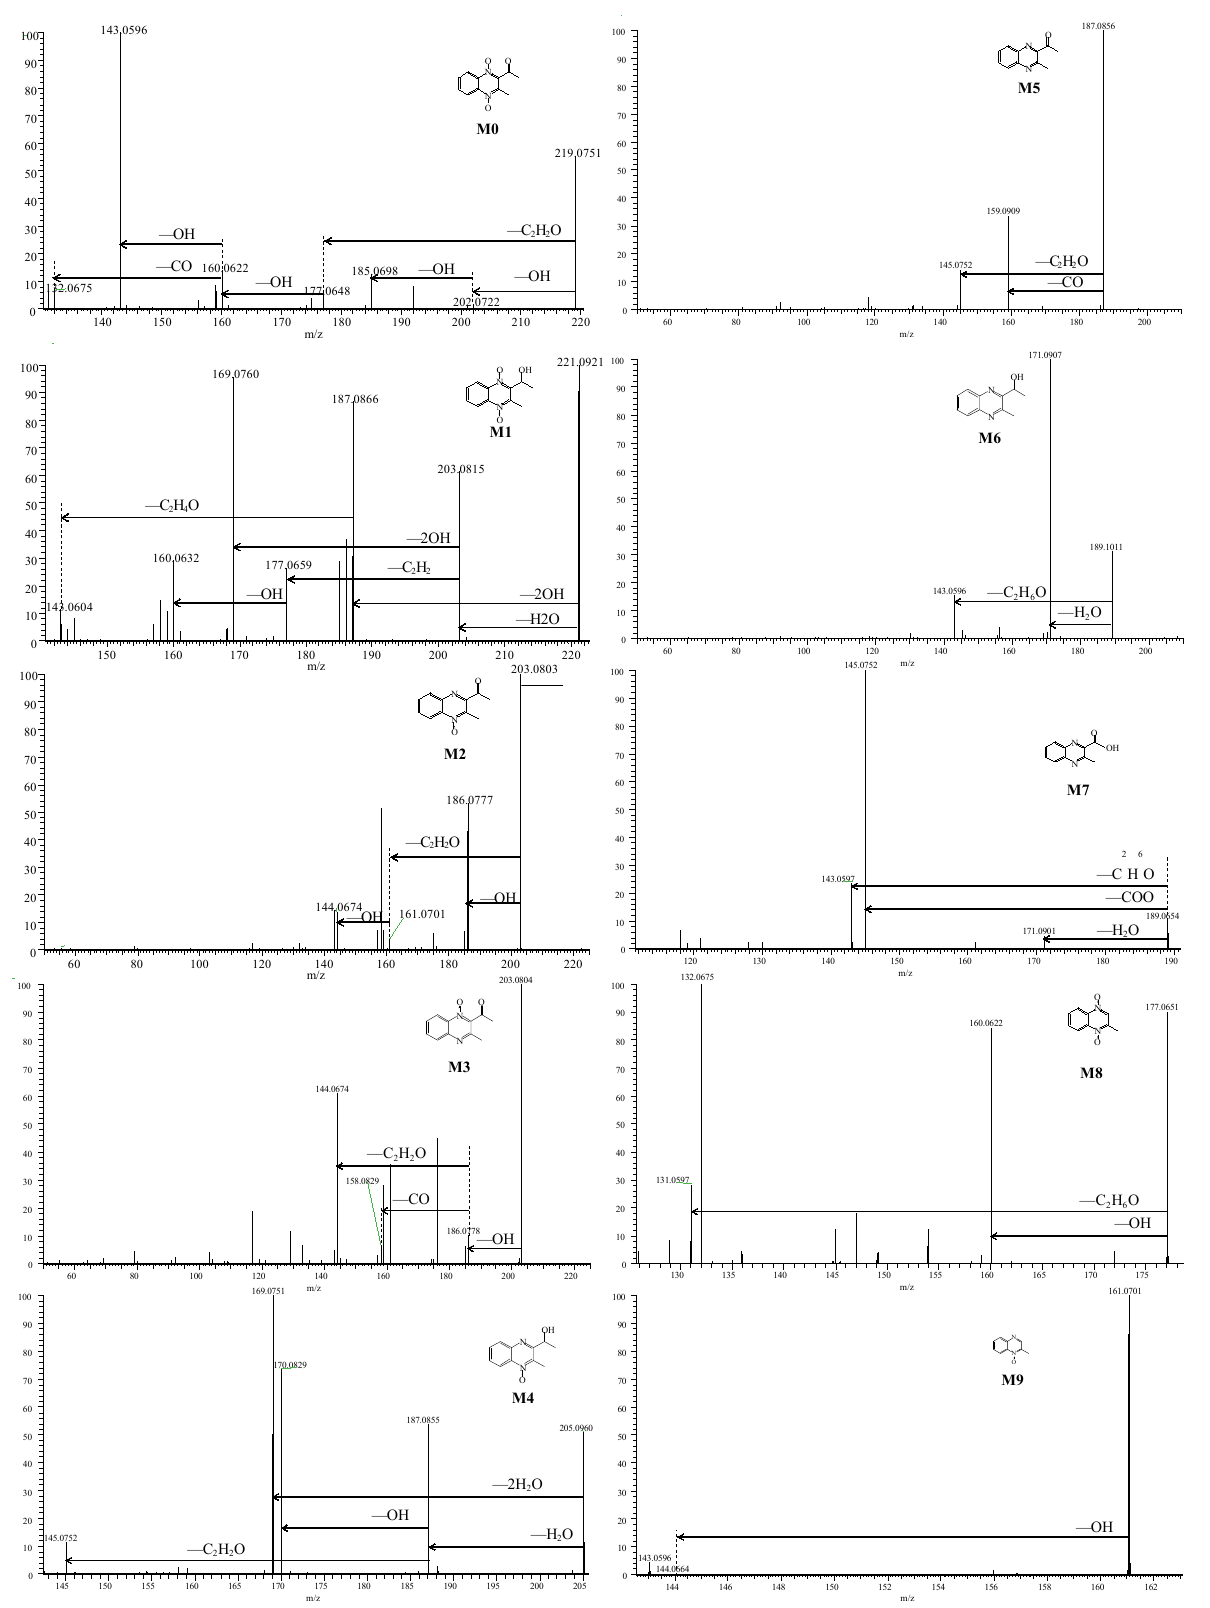
Figure 3. Accurate MS2 spectra and major proposed neutral loss of MEQ and metabolites detected in DDA mode. The MS2 spectra were produced by collision-induced dissociation (CID) of the selected precursor ions with different energies (20, 40, 70).